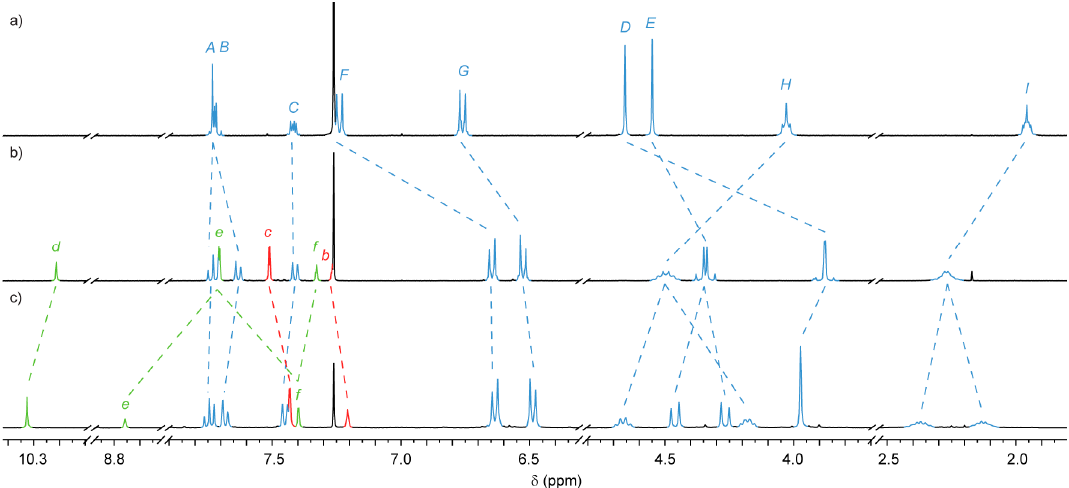
Figure 1. 1 H-NMR spectra (400 MHz, CDCl 3 , 298 K) of ( a ) macrocycle 3 ; ( b ) [2]rotaxane 7 ; and ( c ) [3]rotaxane 8 . For macrocycle and thread labeling see Scheme 2.